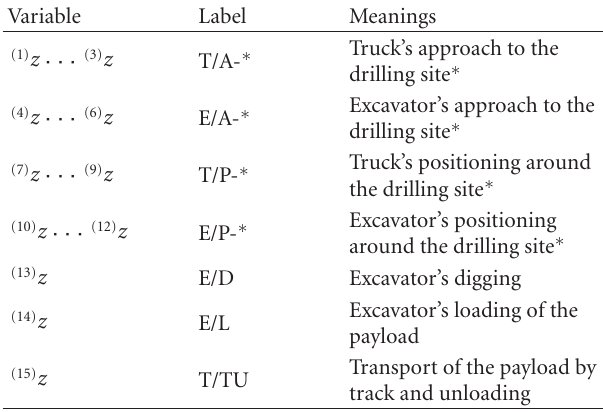
Table 1: Classified operational intention modes, variables, and